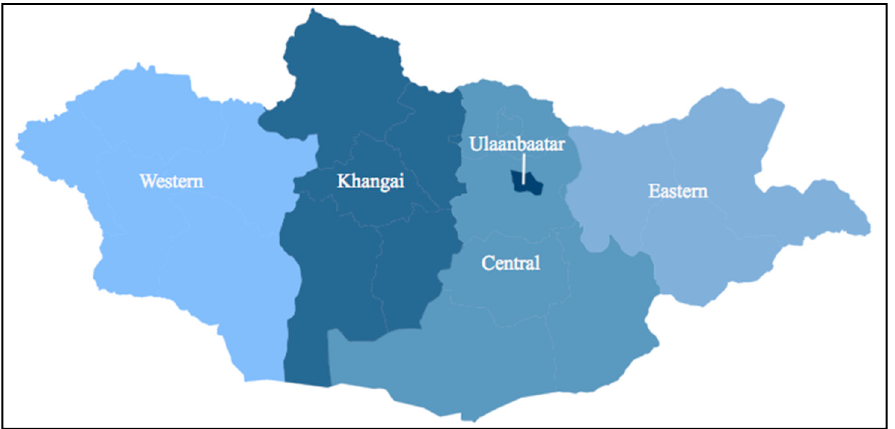
Figure 1. Regional map of Mongolia.